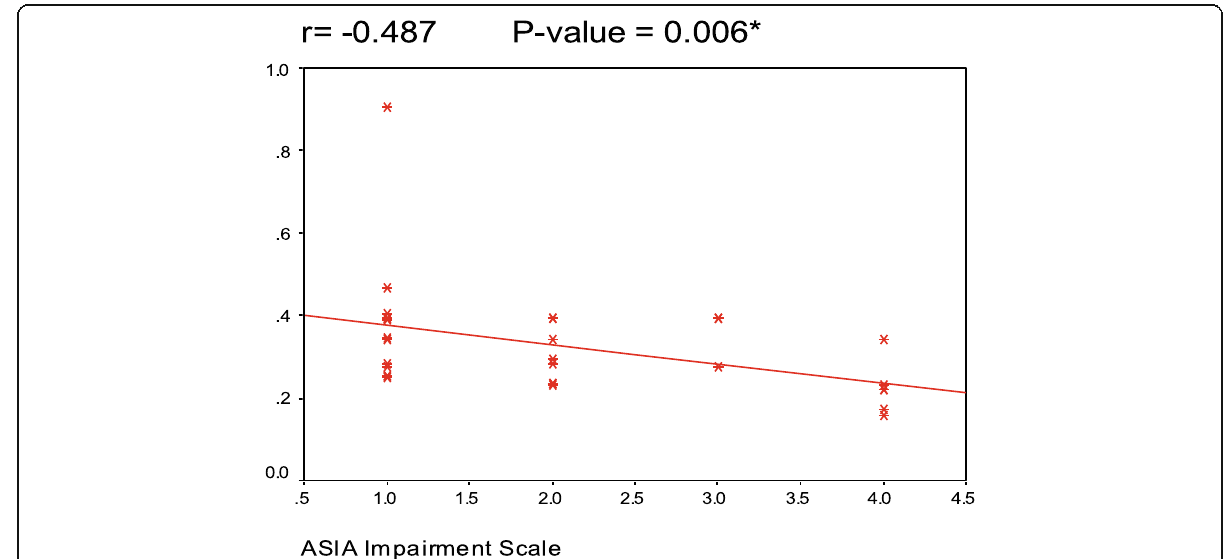
Fig. 8 Spearman ’ s correlation between FA at the level of injury and ASIA impairment scale